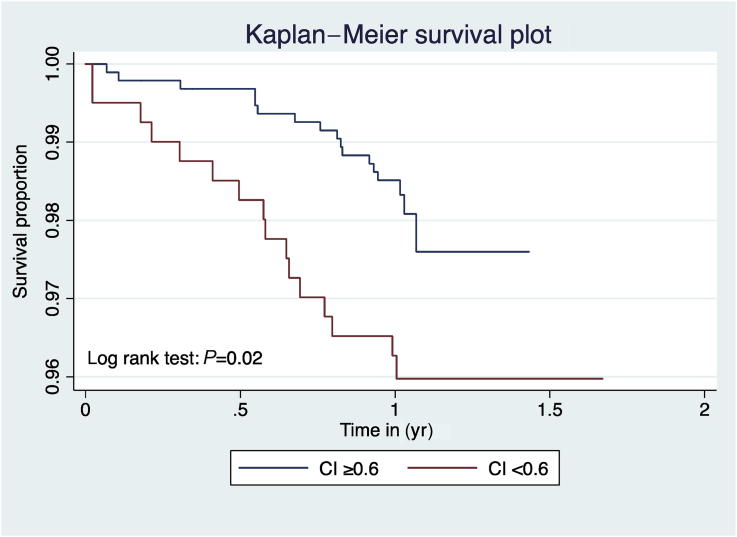
Kaplan–Meier survival plot for chronotropic incompetence (chronotropic index <0.6) vs no chronotropic incompetence (chronotropic index ≥0.6).